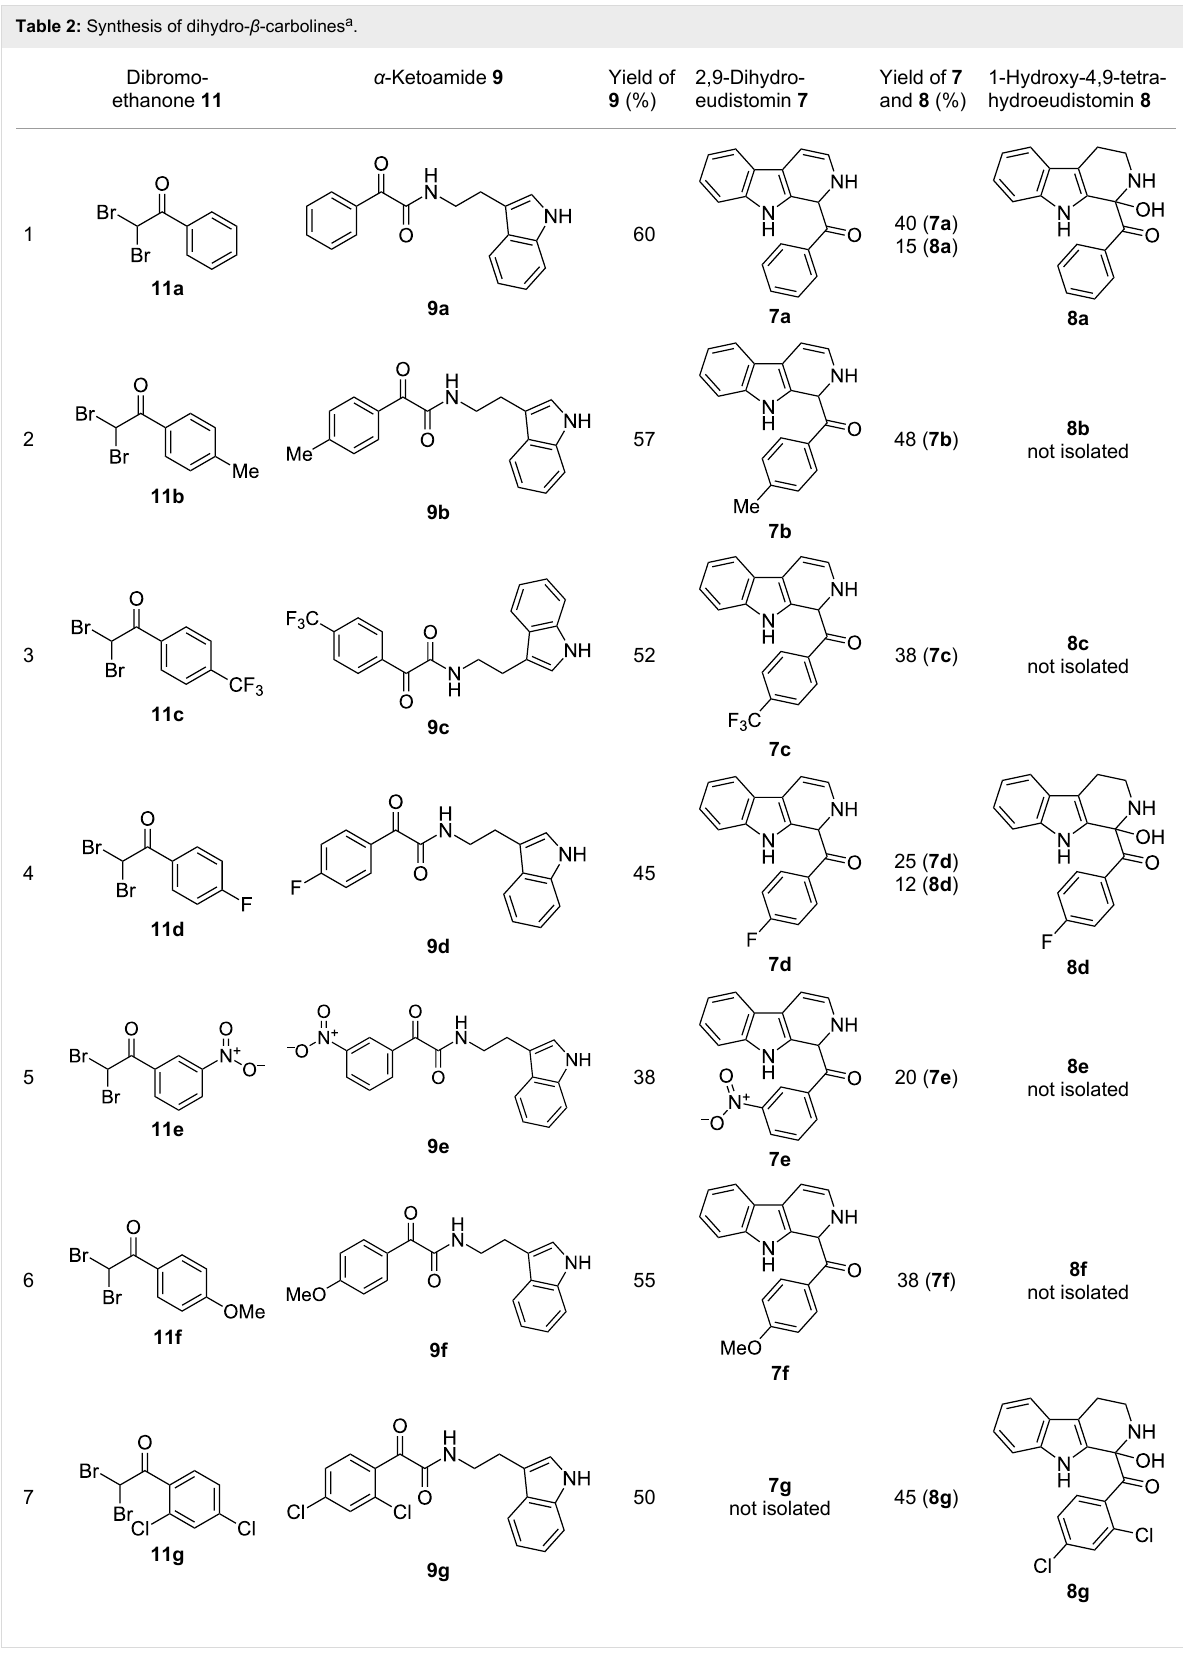
Table 2: Synthesis of dihydro- β -carbolines a . Dibromo- ethanone